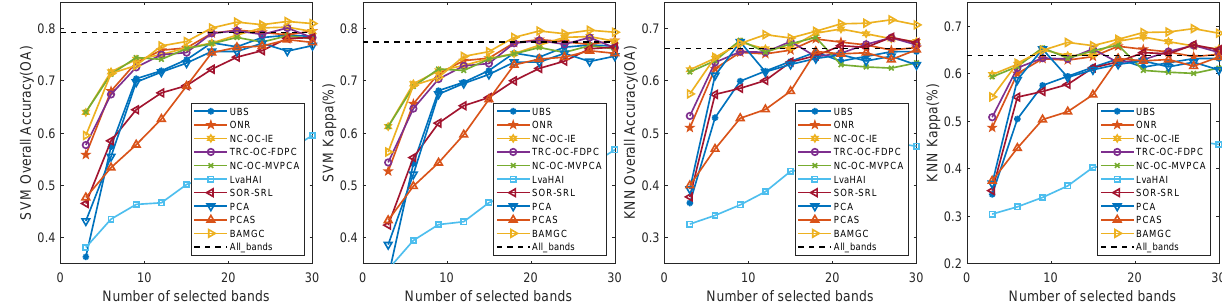
Figure 4. The comparison of OA and κ produced by SVM and KNN on the Indian Pines